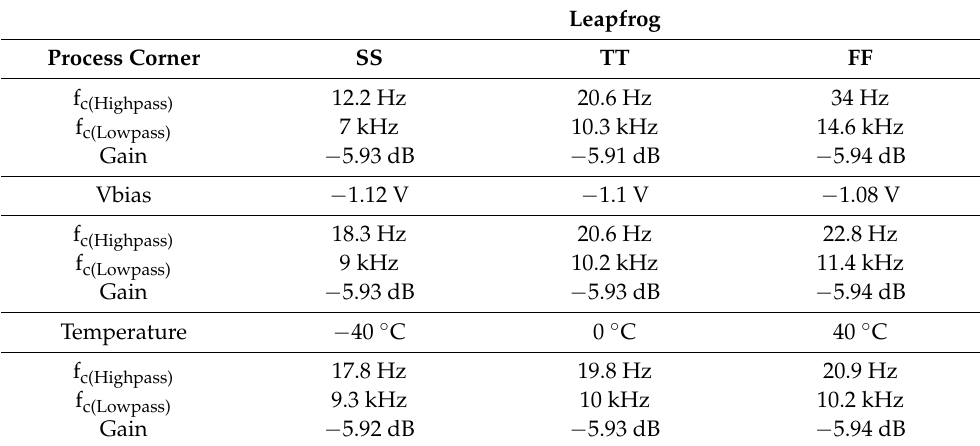
Table 10. PVT corner analysis for the leapfrog filter